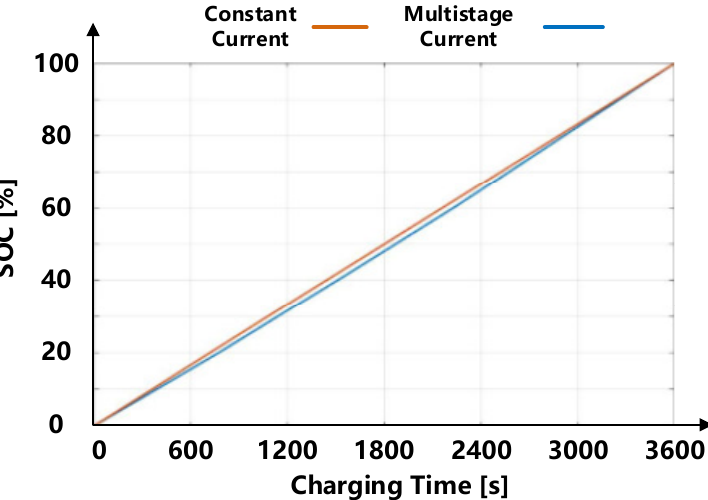
Figure 11. Normalized charging current of multistage current and constant current charging method of one battery in SM of phase A.